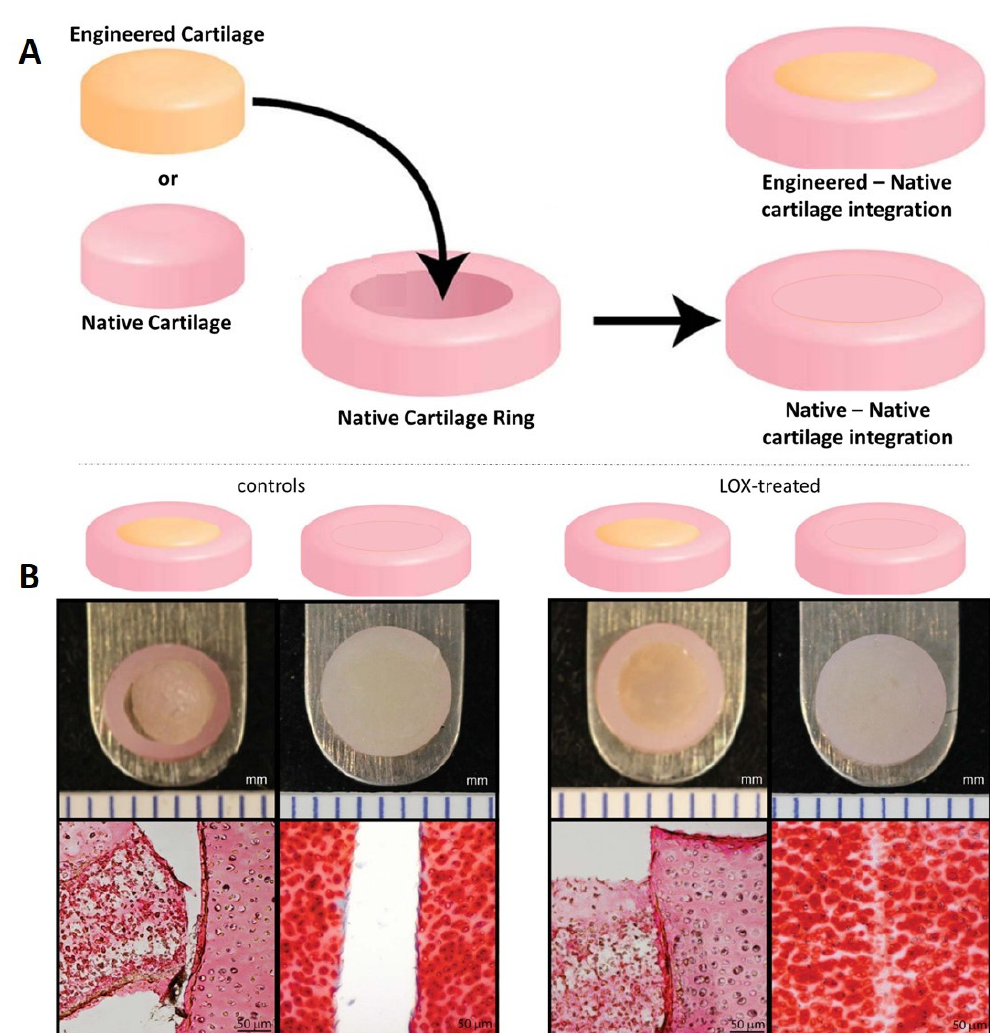
Figure 5. Schematic representation of the approaches examining integration of native or tissue engineered cartilage to native cartilage ( A ) and positive effect of lysyl oxidase (LOX) as enhancer of cartilage integration between native—native and tissue engineered—native cartilage. Native articular cartilage was harvested from distal femurs of one-week old male calves and tissue rings were created ( B ). Cartilage ring was filled with native tissue previously collected during the ring preparation. In parallel engineered cartilage consisting of agarose gel seeded with chondrocytes was also used to fill the cartilage ring. The tissue integration of native to native and engineered—native cartilage was evaluated in presence and absence of lysyl oxidase which induce collagen cross-linking across cartilage interfaces. Images modified from Athens et